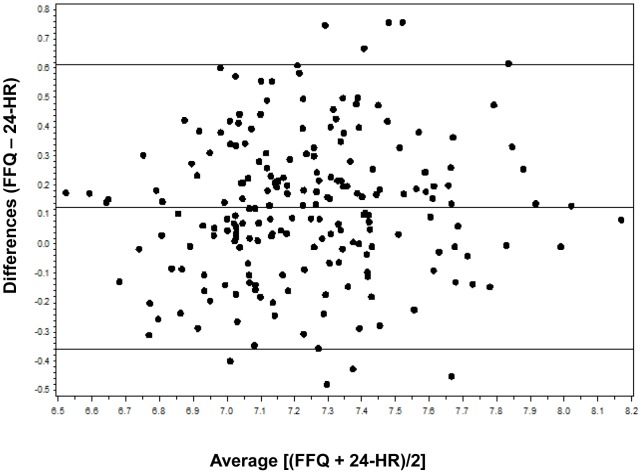
Bland Altman plot analysis of total energy intake.The Y axis is the difference between log-transformed data of total energy intake measured by FFQ (average of FFQ1 and FFQ2) and 24-HRs (average of the four 24-HRs). The × axis is the mean energy intake of the two methods. The central solid horizontal line represents the mean difference between the two methods, and the solid lines above and below it are ±2SDs.